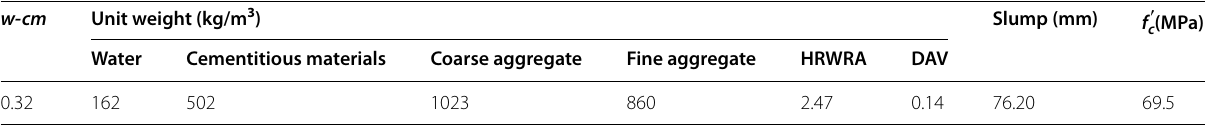
Table 2 Concrete mix proportion and properties.